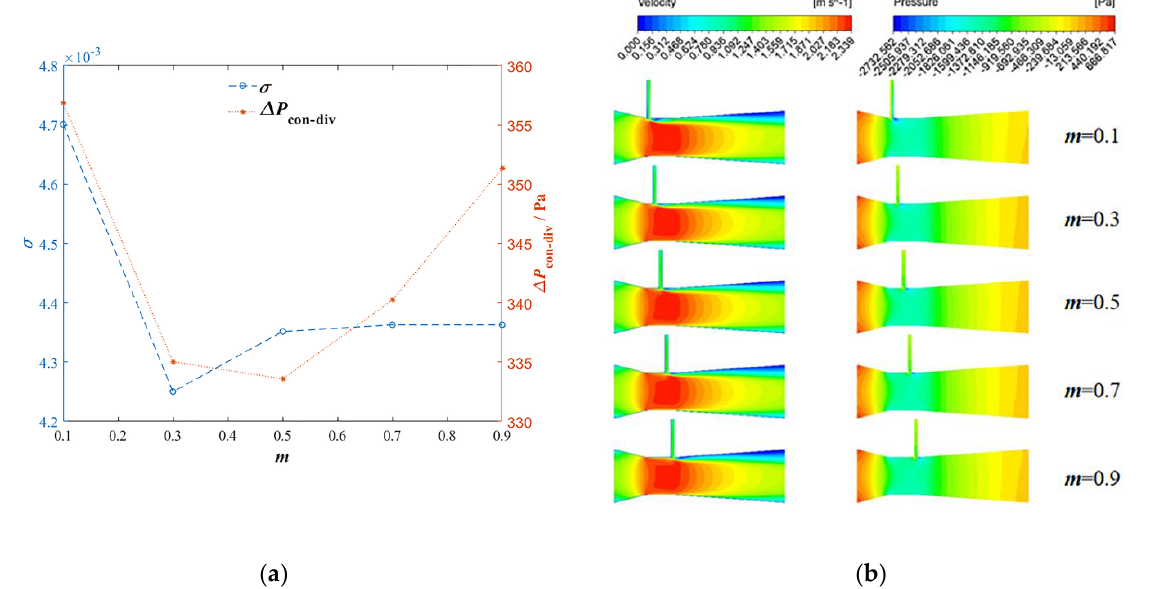
Figure 14. The effects of jetting position on ( a ) ∆ P con-div and σ , ( b ) velocity and pressure distributions in VTM.